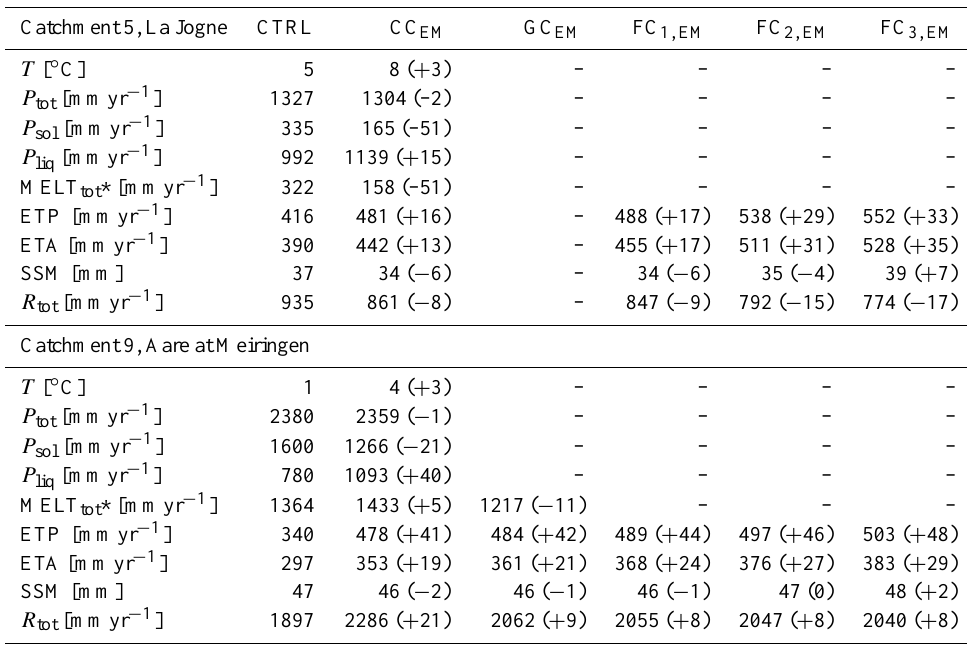
Table 3. Annual values of water balance components for catchments 5 (La Jogne) and 9 (Aare at Meiringen) shown in Fig. 5. The values in brackets are the changes in % relative to the control period, except for temperature where it is the absolute change in K. Catchment 5, La